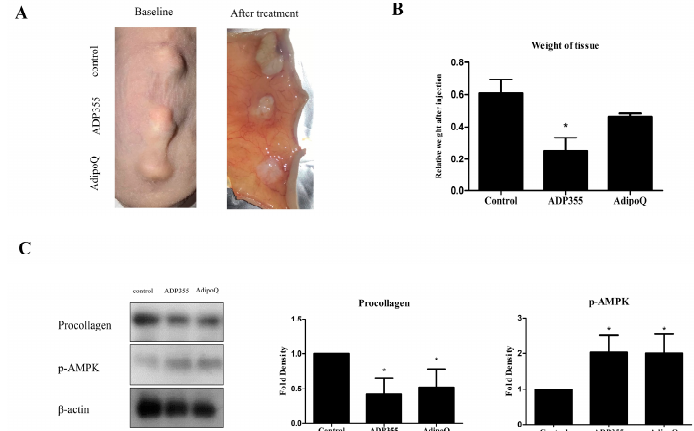
Figure 4. Knockdown of adiponectin receptor 1 (AdipoR1) reversed the ADP355 attenuation of TGF- β 1-induced collagen expression. The effect of adiponectin receptor knockdown was compared with that of a negative control siRNA ( A , * p ≤ 0.05). Knockdown of AdipoR1 reversed the procollagen expression attenuation by ADP355 and adiponectin recombinant, AdipoQ ( B , C , * p ≤ 0.05). The data are expressed as mean ± SD. Representative data are shown from three independent experiments.